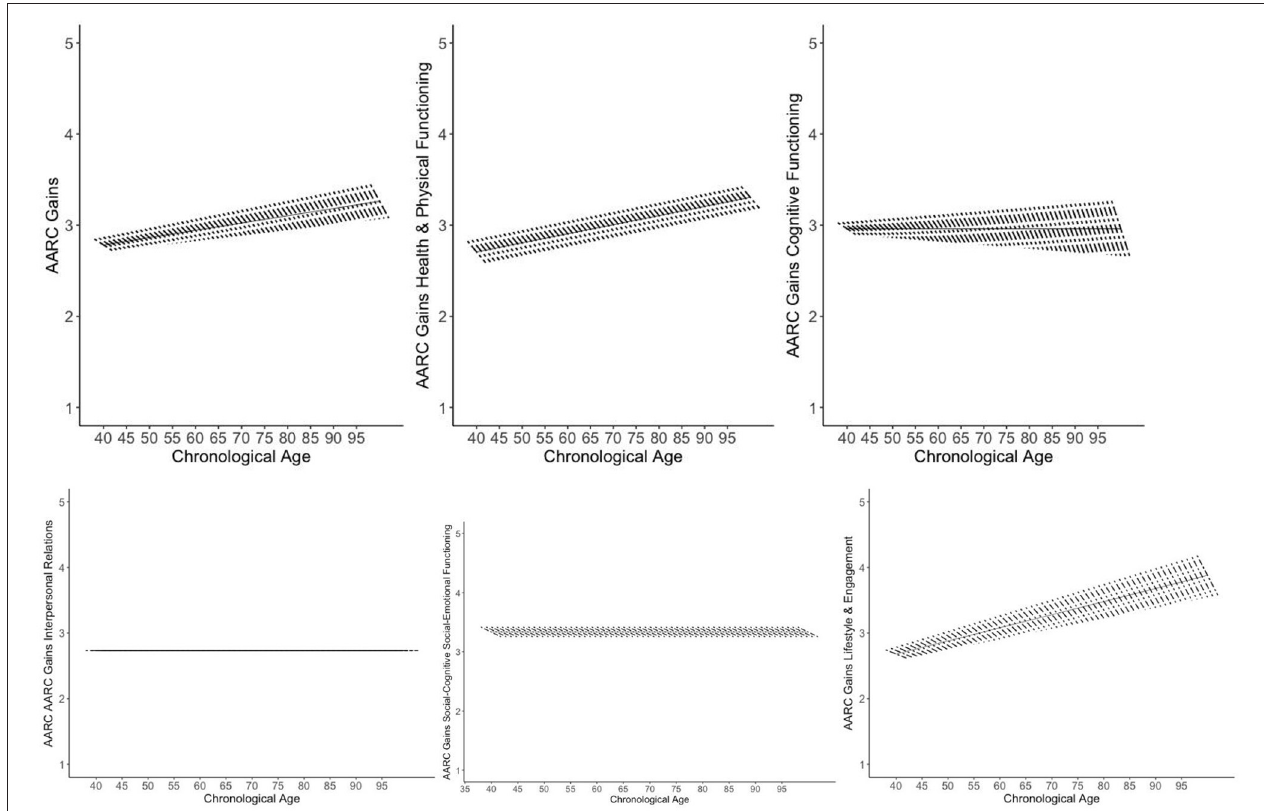
FIGURE 1 | Trajectories of AARC gains. Figures adapted from Gerstorf et al. (84). The figure shows model-implied 5 year within-person changes in AARC gains by baseline age as short, thick lines. The single linear age trend in AARC gains is shown as long, thin line. Models are adjusted for gender, education, and self-rated health. The graphs illustrate a general trend of 5 year declines in AARC gains across the different domains (with the exception of interpersonal relations, which—on average—remained stable over 5 years). At the same time, baseline AARC gains in general as well as with regard to health and physical functioning were greater among older adults compared to middle-aged individuals. Gains in lifestyle and engagement at baseline were nonlinearly related with age (see Supplemental Figure 1